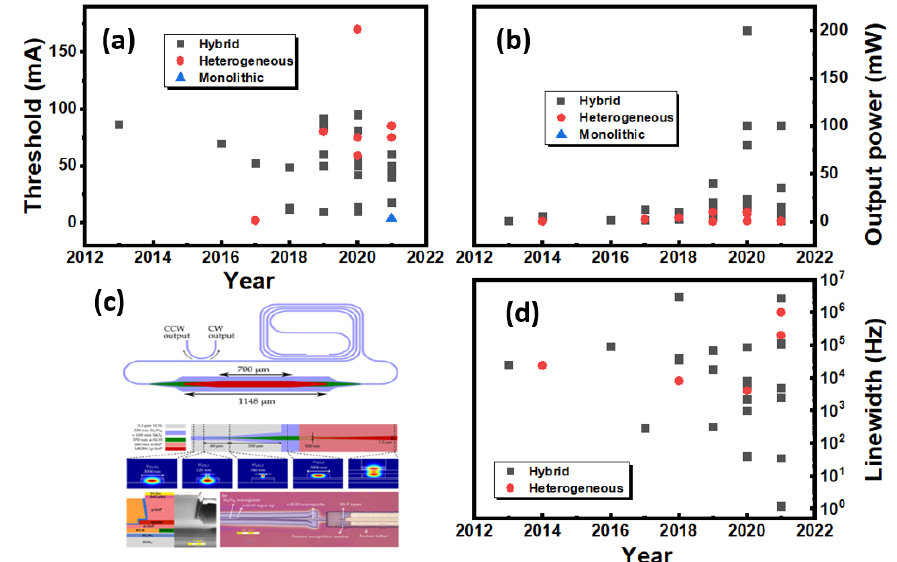
Figure 11. Development of ( a ) threshold current and ( b ) maximum output power of III-V/SiN- coupled lasers [239,244–280], ( c ) schematic layout of a heterogeneous III-V/SiN laser and its optical taper between SiN and III-V gain sections [245] and ( d ) development of linewidth of III-V/SiN lasers